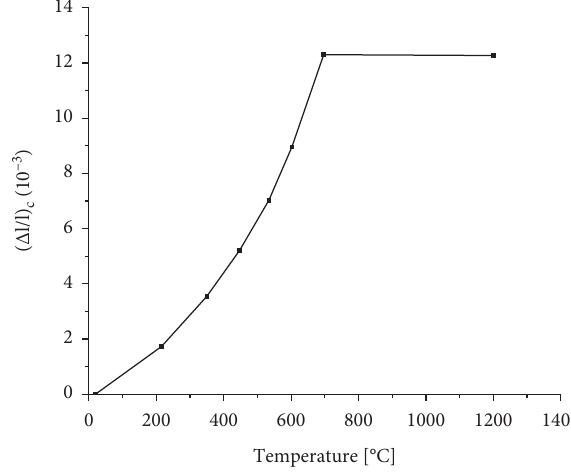
Figure 9: Coefcient of thermal expansion [19].